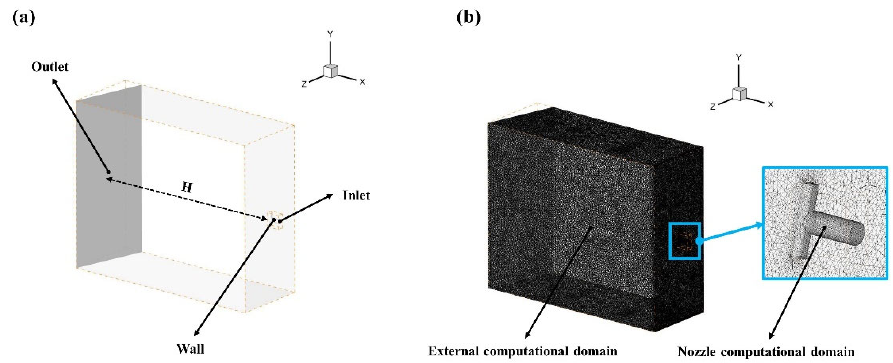
Figure 3. A schematic diagram of the physical model and meshing of hot rolling: ( a ) physical model; ( b ) unstructured grid.